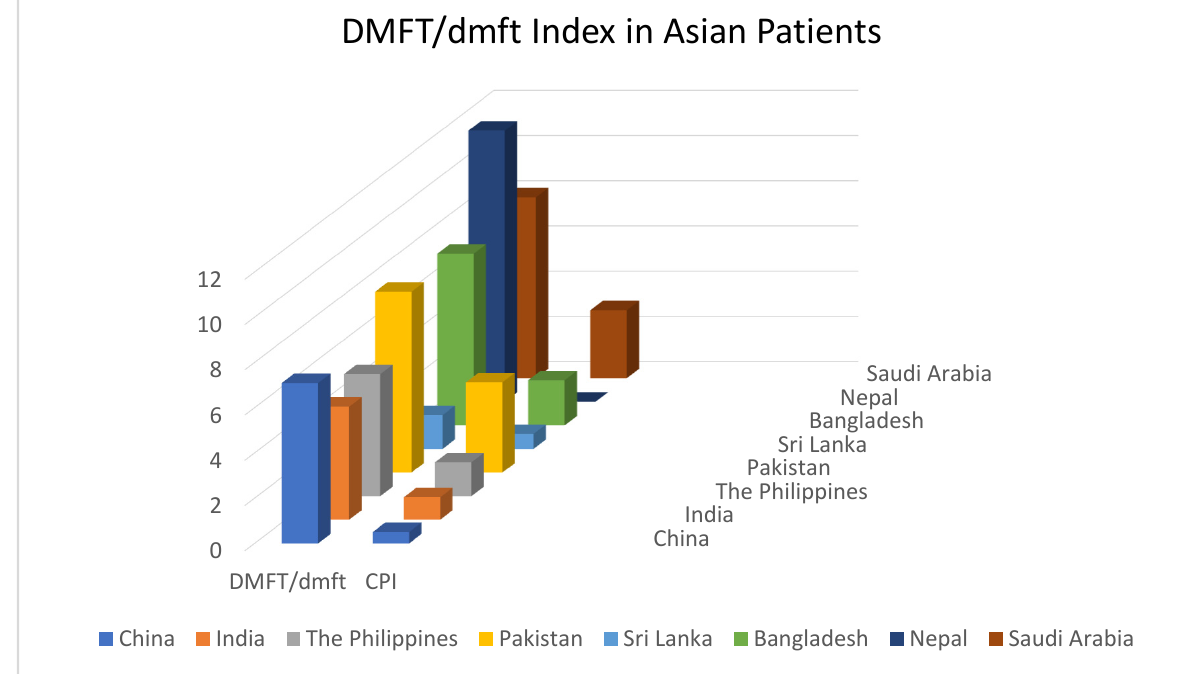
Figure 4. DMFT/dmft Index and CPI (means) in Asian patients.